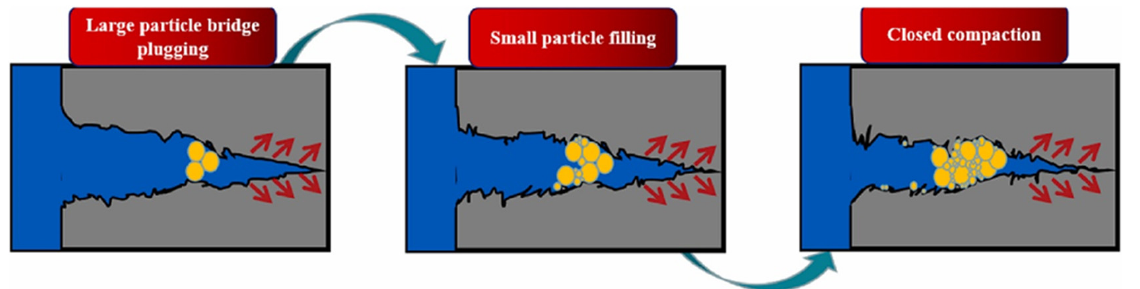
Figure 15. Plugging mechanism of PPGs in fractures. (Reprinted/adapted with permission from Ref. [42], 2022, Zhou et al.).